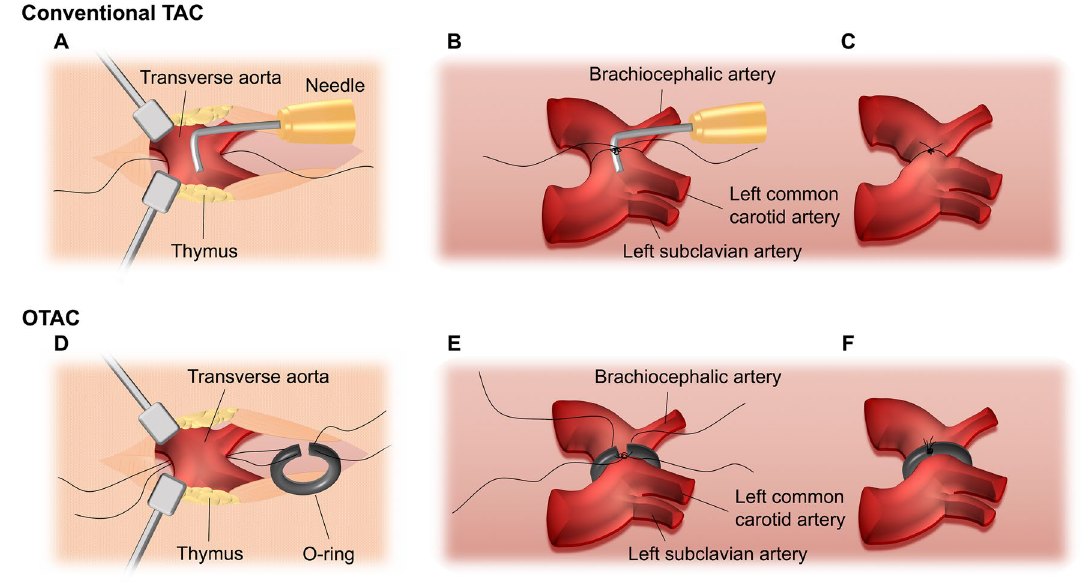
Figure 1. ( A–C ) Schematic of conventional transverse aortic constriction (TAC). ( A ) A small piece of a 6.0 silk suture is placed under the transverse aorta (between the brachiocephalic and left common carotid arteries). A blunt needle is placed parallel on the transverse aorta. ( B ) The suture is tied with triple knots against the needle. ( C ) The needle is promptly removed, and the excess suture is cut. ( D–F ) Schematic of O-ring-induced transverse aortic constriction (OTAC). ( D ) Two sutures penetrate the end of the o-ring (The details on the preparation of the o-ring are described in Supplemental Fig. 3). The o-ring is passed from the cranial side to the caudal side under the transverse aorta (between the brachiocephalic and left common carotid arteries). ( E ) The o-ring is placed around the transverse aorta. ( F ) Two sutures are tied with a triple knot, and the excess suture is cut. The details of the OTAC procedure are described in Supplemental Fig.